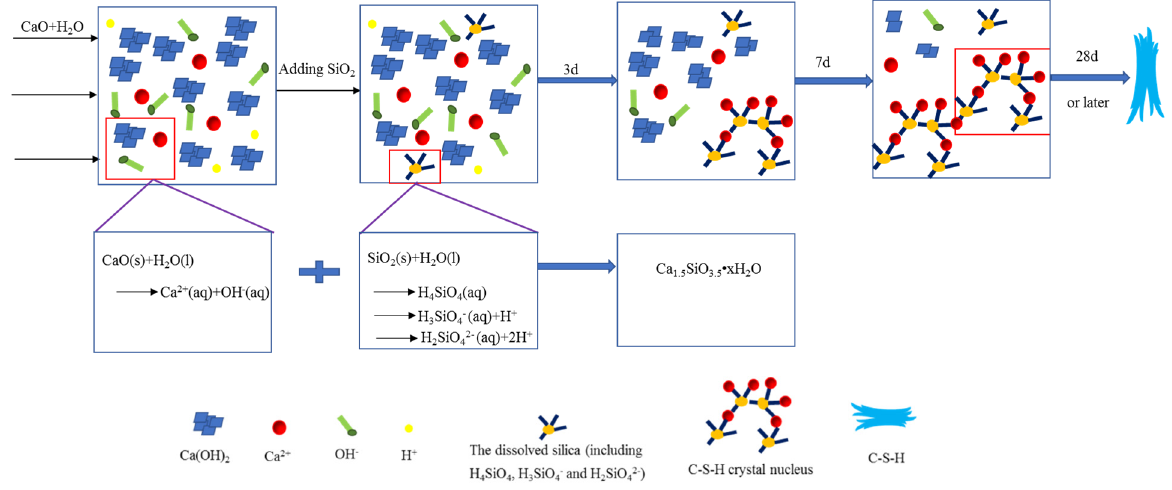
Figure 12. Schematic diagram of the formation of C-S-H.